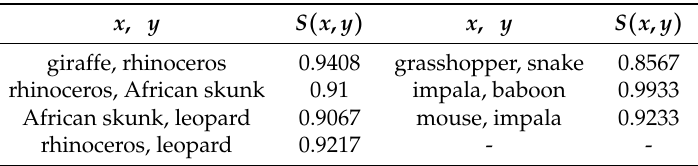
Table 6. Strength of common enemies between